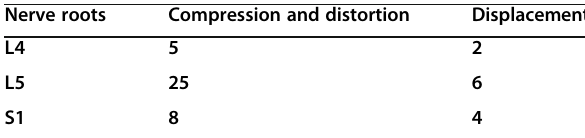
Table 4 Involvement of spinal nerve roots on DTI-fiber